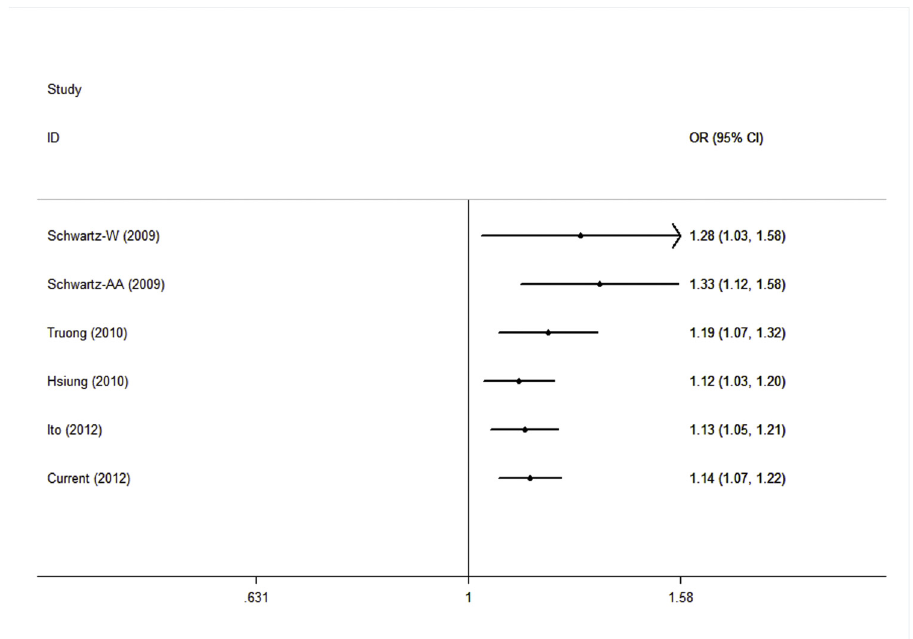
Fig 2. The cumulative meta-analysis of association rs931794 with lung cancer risk under dominant model.